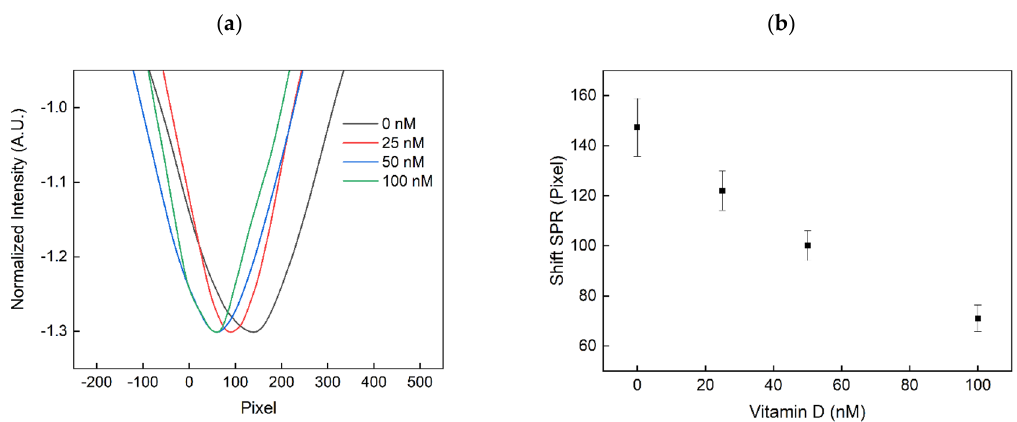
Figure 6. Measured sensor spectrum ( a ) and the resulting shift of the SPR signal obtained after calculating the position of the “centre of mass” of SPR sensor spectra for increasing Vitamin D concentrations ( b ).